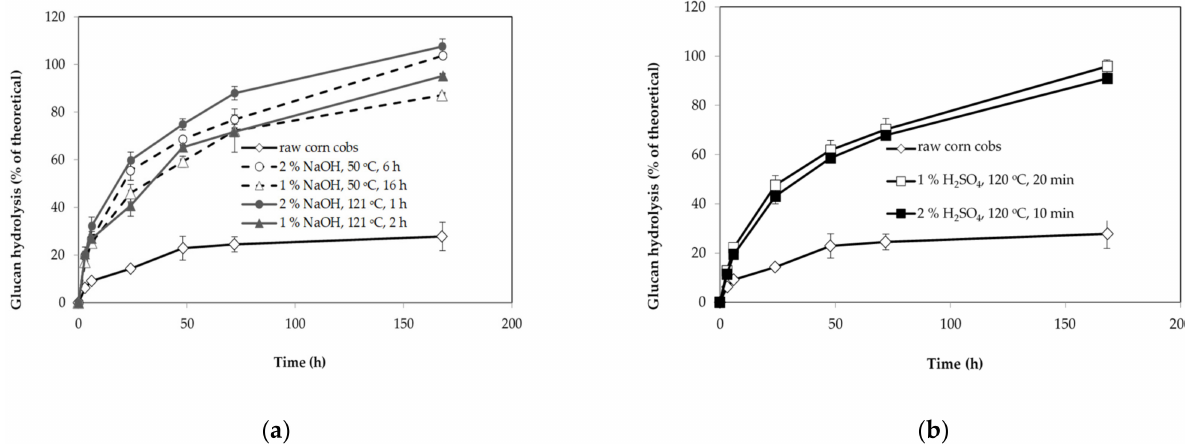
Figure 2. The efficiency of enzymatic hydrolysis of glucan from raw and pretreated corn cobs with sodium hydroxide: (( a ) 1% NaOH, 50 ◦ C, 16 h; 2% NaOH, 50 ◦ C, 6 h; 1% NaOH, 121 ◦ C, 2 h and 2% NaOH, 121 ◦ C, 1 h) and sulfuric acid; (( b ) 2% H 2 SO 4 , 120 ◦ C, 10 min and 1% H 2 SO 4 , 120 ◦ C, 20 min). Glucan hydrolysis efficiency was calculated based on the total conversion of glucan from